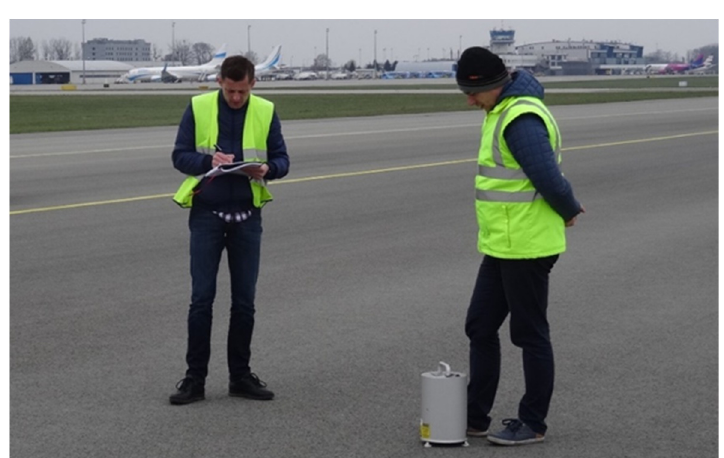
Figure 5. ELATextur measurement.